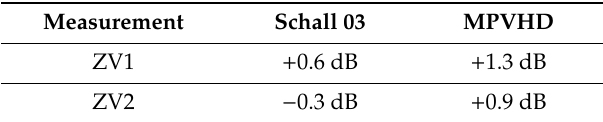
Table 3. Comparison of the measurement and prediction